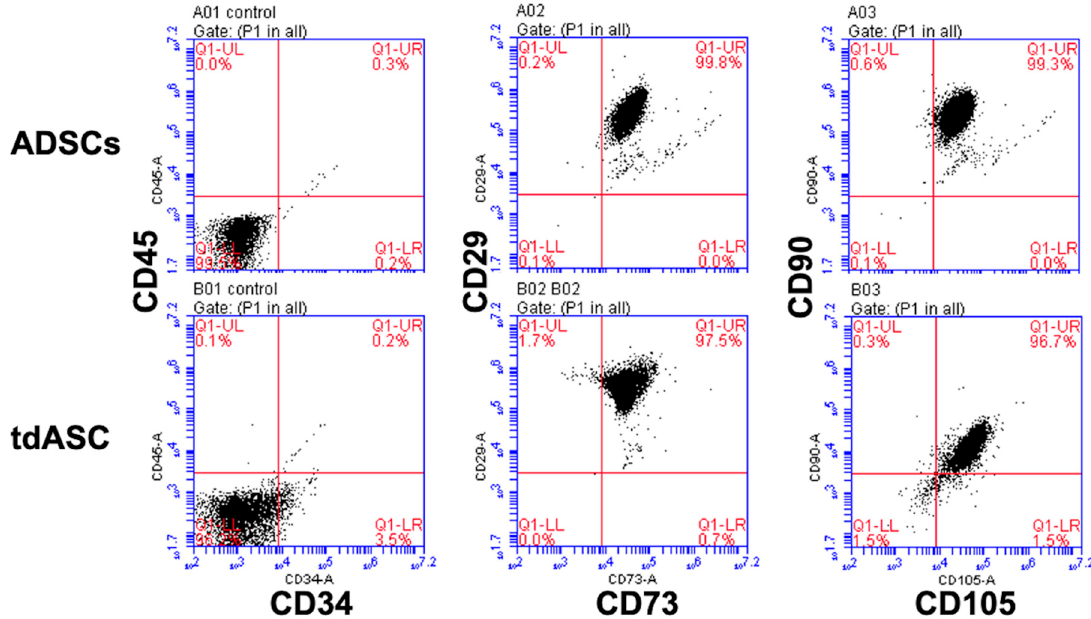
Figure 2. Immunophenotyping of ADSCs and tdASC by FCM analysis. P3–4 ADSCs and tdASC were positive for MSC markers CD29, CD73, CD105, CD90, and negative for CD34 and CD45.